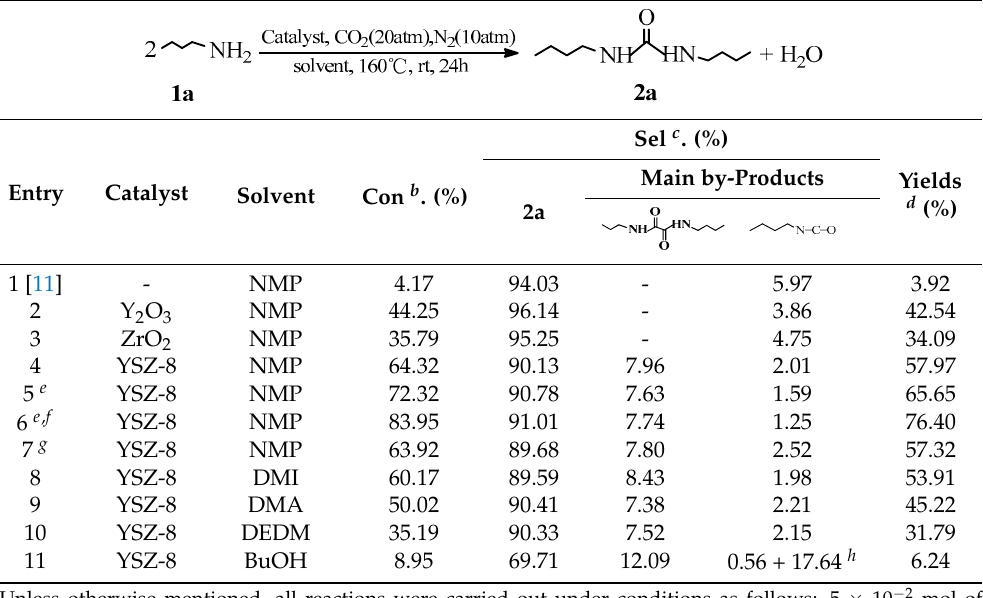
Table 1. Results for carbonylation of 1-butanamine (1a) to the corresponding N , N ′ -dibutylurea (2a) with CO 2 a .